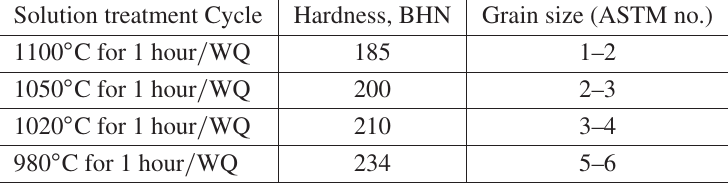
Table 3. Heat treatment cycle and corresponding hardness and grain size.